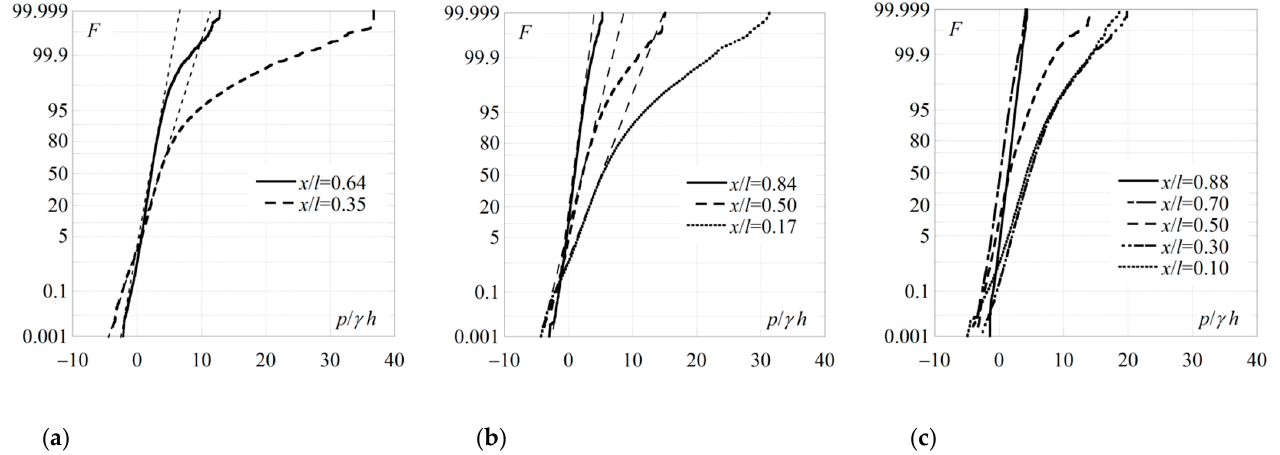
Figure 8. Probability distribution function F of fluctuating pressures yet uninfluenced by the slope reduction, for d c / h = 4.6 and ( a ) 50° module (step − 3), ( b ) 30° module (step 31, and ( c ) 18.6° module (step 20). (—) Normal distribution.